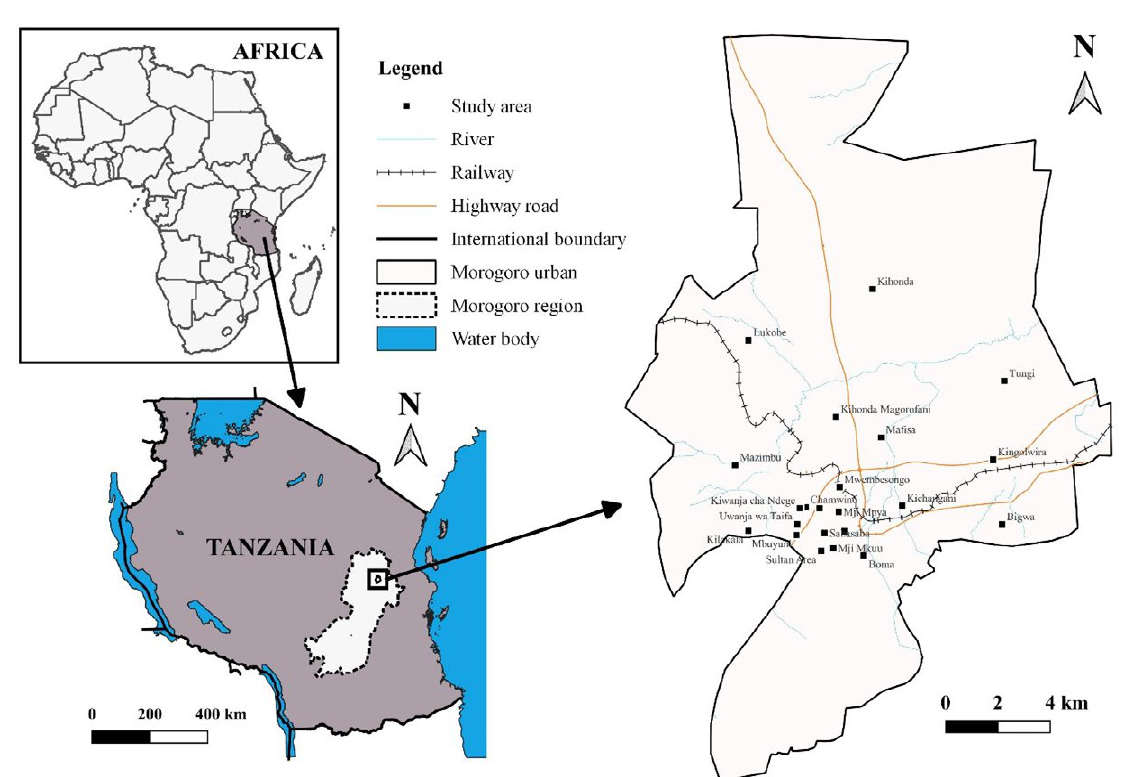
Fig. 1: Map of the study area of the Municipality of Morogoro from Morogoro Region in Fig. 1: Map o f the study area of the Municipality of Morogoro from Morogoro Region in Tanzania